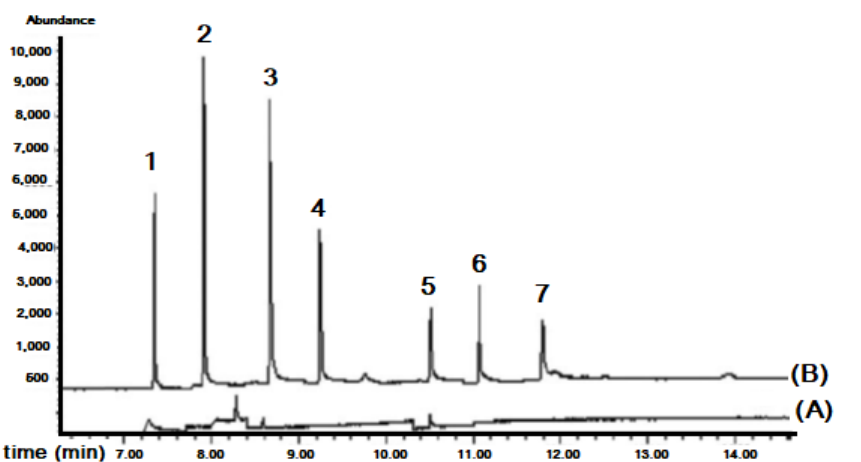
15 of 21 Figure 13. Schematic illustration of the in ‐ syringe ‐ DLLME–GC/MS setup for on ‐ line preconcentra ‐ tion and determination of phthalates. DR: dispersive reagent (acetone), ER: extraction reagent (tri ‐ chloroethylene), HC: holding coil, MIV: microinjection valve, MPV: multiposition valve, MSM1–2: multisyringe module 1–2, S1–2: syringe pump 1–2, SV: solenoid valve and V1–2: valve 1–2 [48]. To investigate the effect of sample matrices on extraction efficiency, these samples